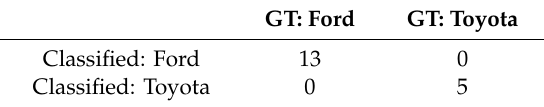
Table A2. Confusion matrix for the IMG429 video: 50% missing pixels trial with YOLO